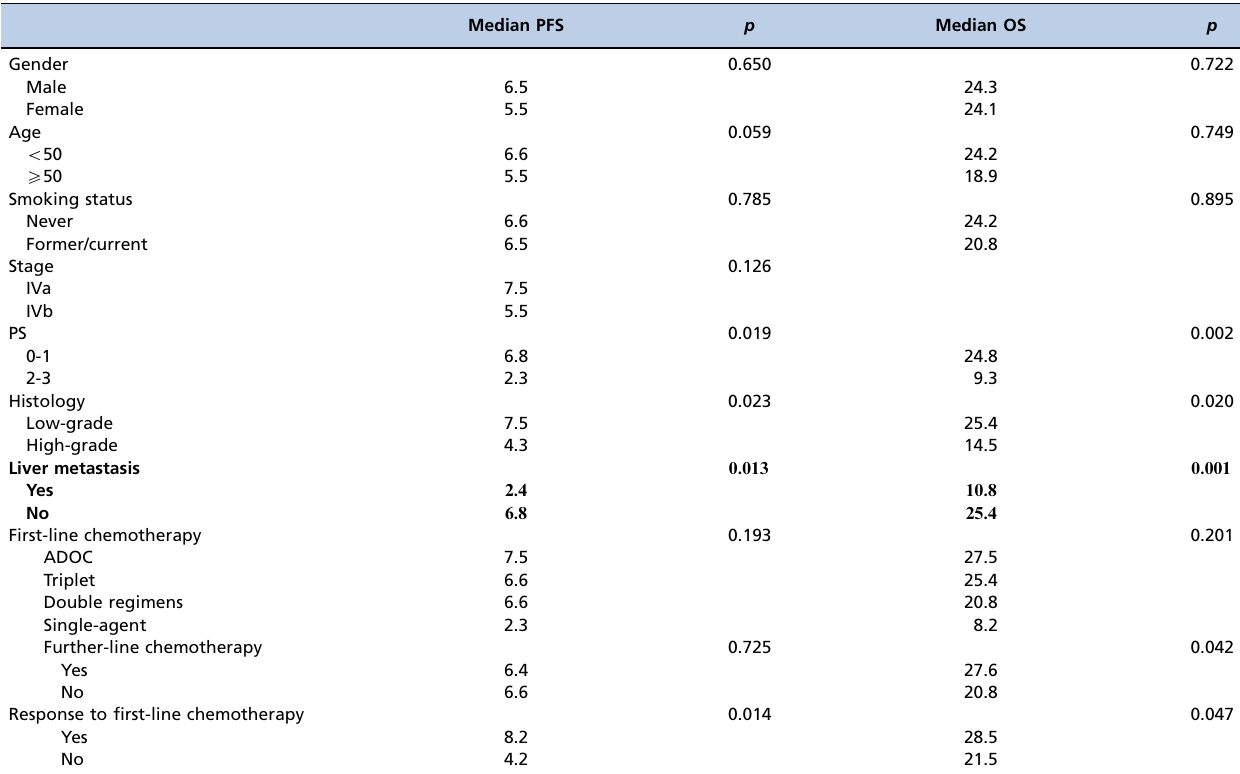
Table 3 - Univariate analysis of the patient survival according to the clinicopathologic